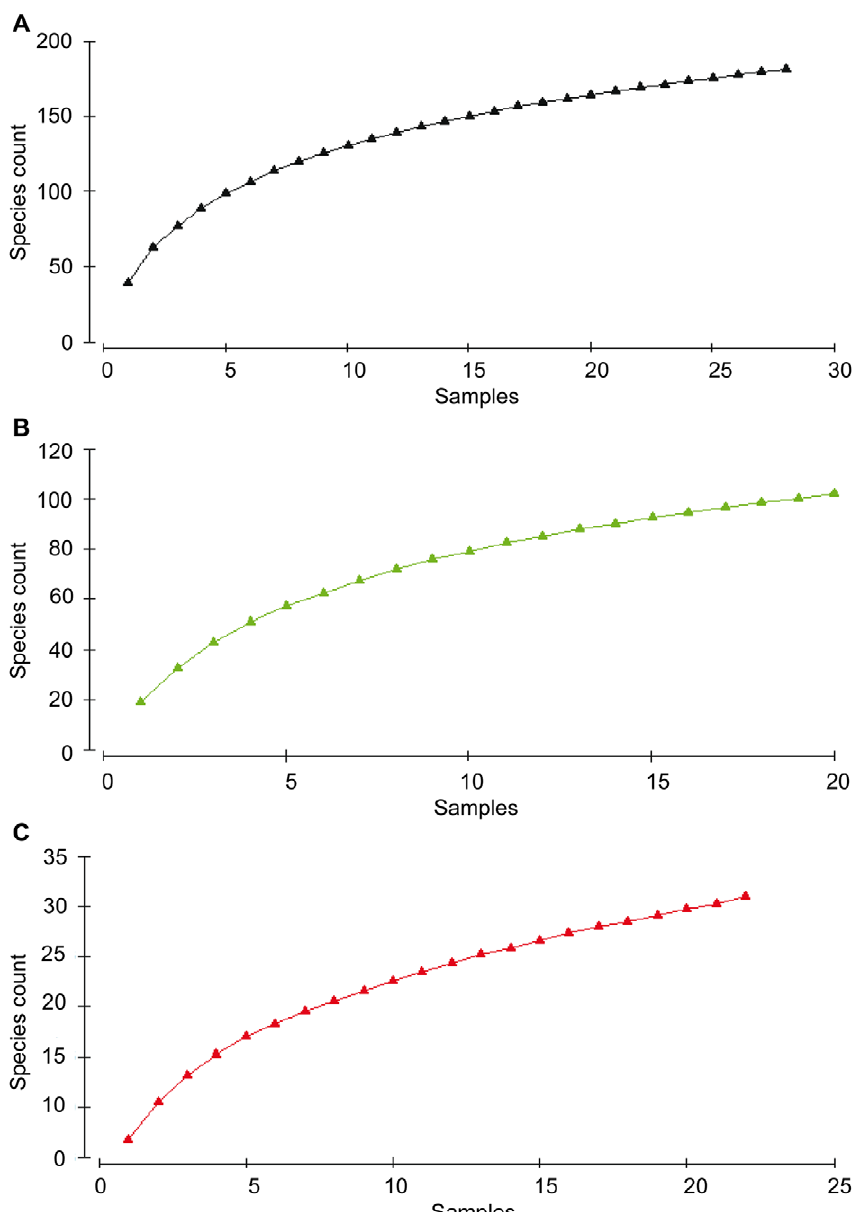
Figure 2. Permuted sample-based rarefraction curves for observed genera in deep-sea control samples: A. 27 samples (black colour code), cold seeps ; B. 20 samples (green colour code), and hydrothermal vents; C. 22 samples (red colour code).